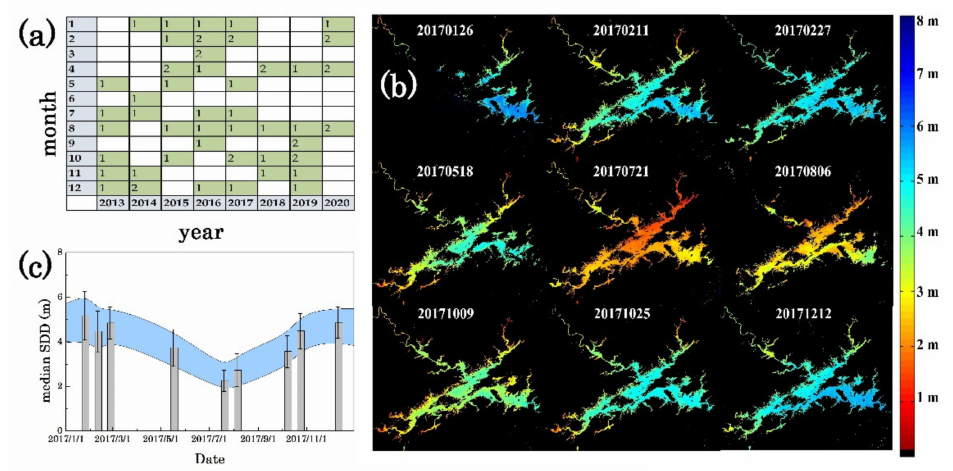
Figure 6. ( a ) Valid OLI images from January 2013 to August 2020; ( b ) Spatial and ( c ) median SDD variability in 2017.